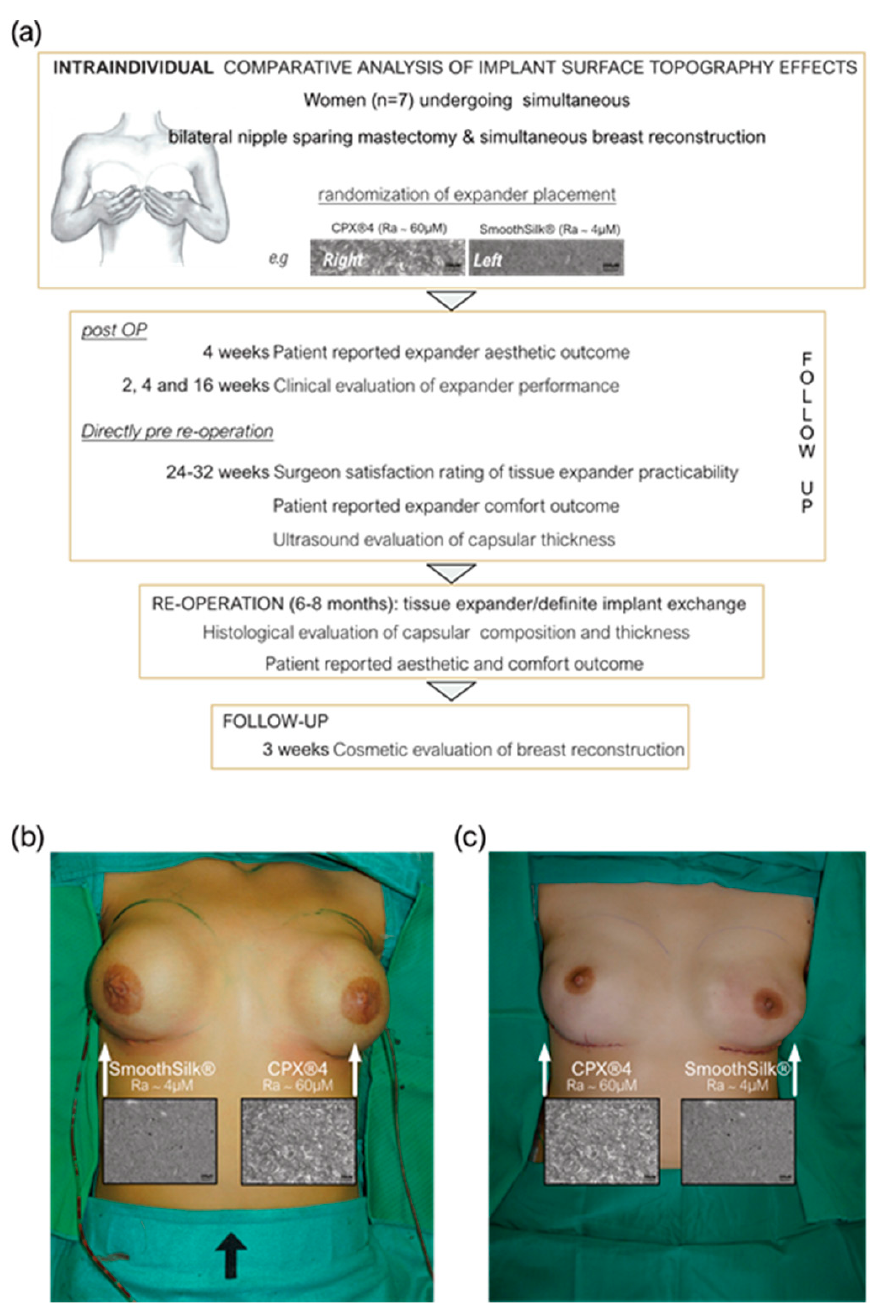
Figure 1. Expander immunology Trial (ClinicalTrials.gov ID: NCT05648929. ( a ) Assessment schedule pre- and after-expander implantation. ( b , c ) Standardized intra-operative photo documentation of an intra-individual comparative bilateral tissue expander-based breast reconstruction. Each patient received both types of expanders, the routinely used CPX ® 4 breast expanders (MENTOR ® , USA: surface roughness: ~60 µM Ra) and the novel surface-roughness reduced SmoothSilk ® breast expanders (Motiva Flora ® , Establishment Labs, Costa Rica: surface roughness: ~4 µM Ra) randomized to the left or right breast in combination with TiLOOP ® pocket mesh after bilateral prophylactic NSME. ( b ) Patient 003; Right: SmoothSilk ® , Left: CPX ® 4, ( c ) Patient 001; Right: CPX ® 4, Left: Smooth- Silk ® . Table 3. Summary of patient demographic characteristics and device information.